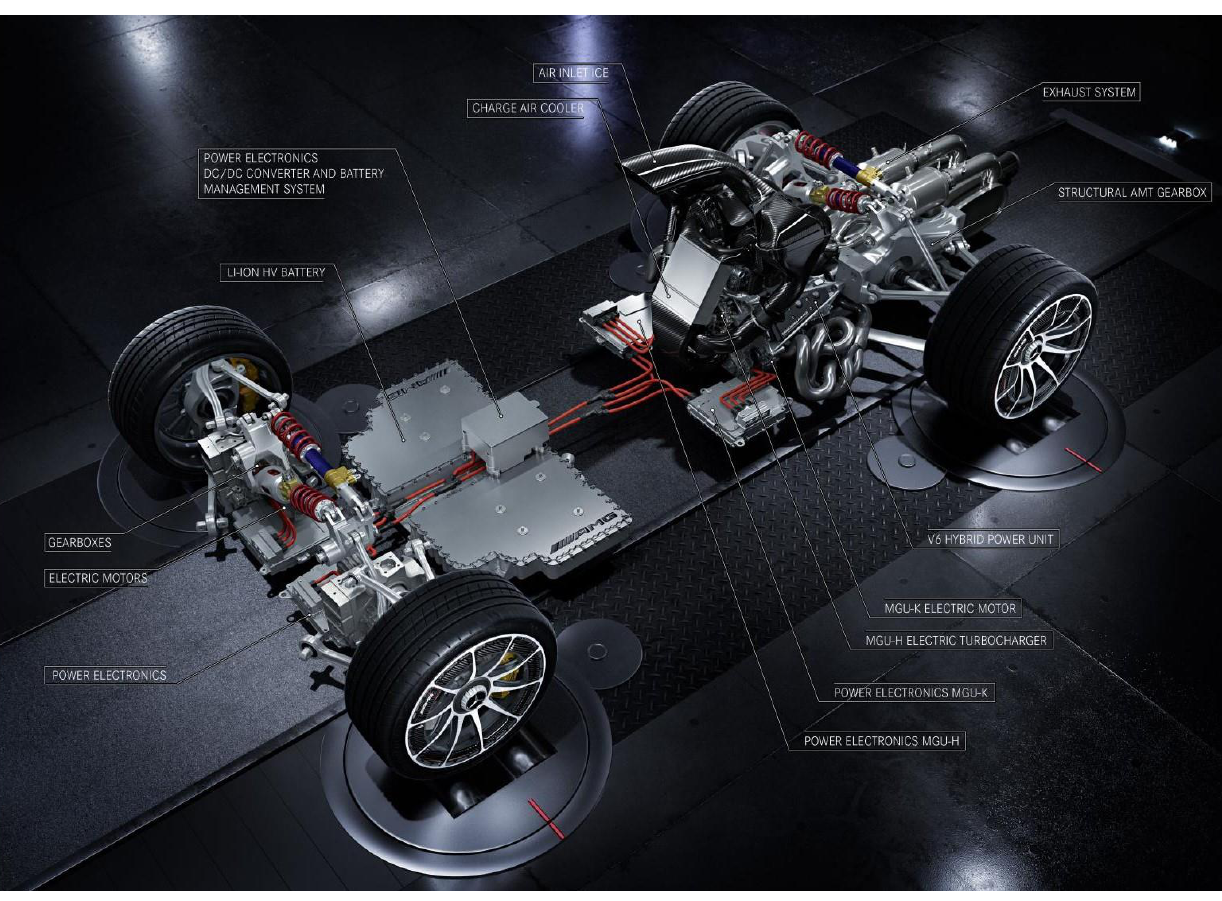
Fig. 13. Mercedes-AMG Project ONE – powertrain overview